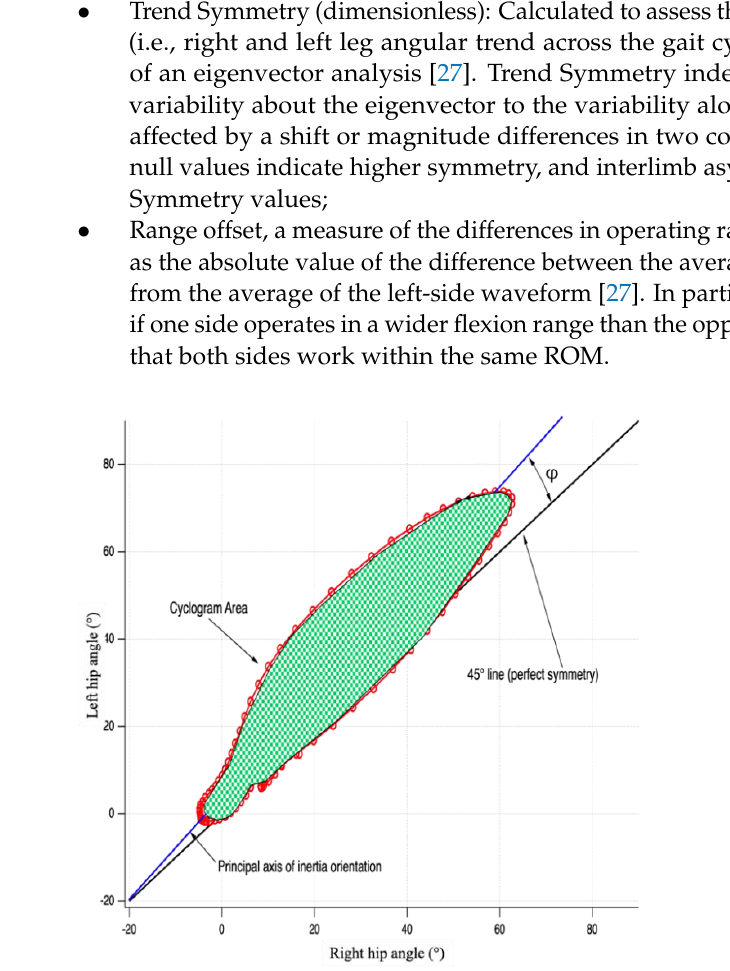
Figure 1. Graphic representation of a cyclogram and its main features considered for the present study.